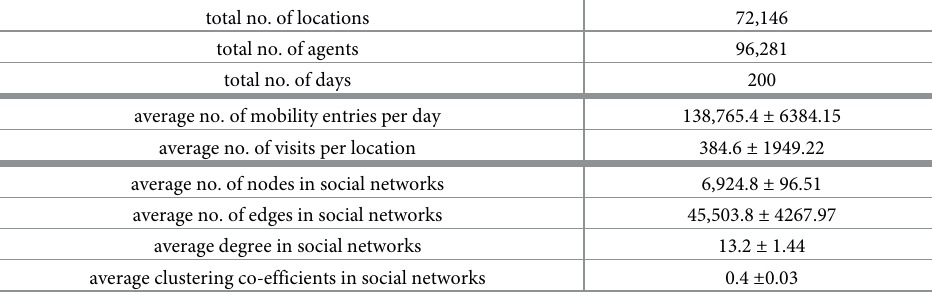
Table 1. Summary statistics on the mobility log and the resulting social